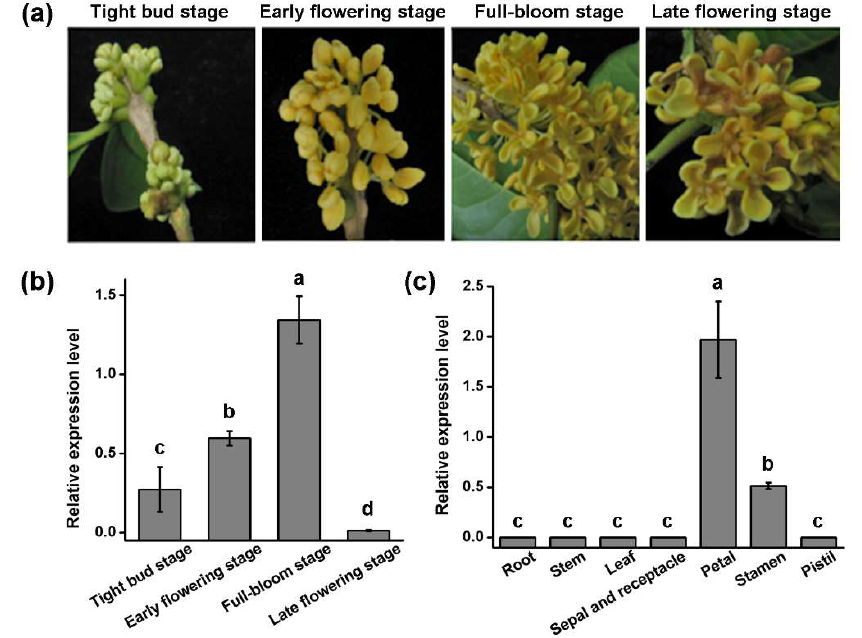
Figure 3. Expression profile of OfGLO1 in different flower organs of O. fragrans . ( a ) The phenotypes of O. Fragrans flowers at four different floral stages. ( b ) The expression levels of OfGLO1 in O. Fragrans flowers at four different floral stages. ( c ) The expression levels of OfGLO1 in different tissues of O. fragrans at the full-bloom stage. Quantitative real-time RT-PCR was used to determine the relative expression levels, and cytokine gene ( qActin , Table S1) was used as the internal reference gene. The different letters indicate significant differences according to ANOVA followed by Duncan’s test ( p < 0.05). Data are means (±SD) from three biological replicates.